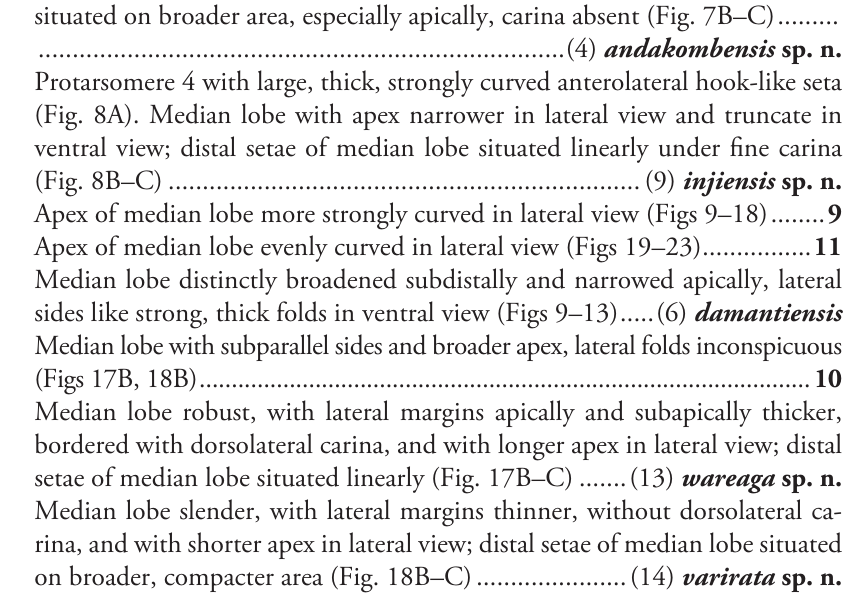
– Beetle larger, TL-H: 3.9–4.5 mm, with darker dorsal coloration, shiny, with evident microreticulation and weak punctation (Figs 25–26) ...................... 3 3 Median lobe with apex slightly curved, elongate in lateral view and rounded in ventral view; numerous fine setae situated linearly on distal part of median lobe along the lateral sides (Figs 2–3, figs 76, 82 in Balke (1998)) ...........(1) miriae – Median lobe with apex slightly curved, broad in lateral view and concave in ventral view, and with a small bunch of fine distal setae on both lateral sides (Fig. 4B–C) ....................................................................... (3) tekadu sp. n. 4 Beetle matt dorsally due to strong microreticulation and punctation .......... 5 – Beetle shiny, with evident microreticulation and weak punctation .............. 8 5 Median lobe narrow, with slightly curved, broad apex and few fine distal setae in lateral view (Fig. 5B–C) .....................................(10) kabwumensis sp. n. – Median lobe broader, with numerous thick setae in lateral view (Figs 6–8) ... 6 6 Beetle larger, TL-H: 3.6–4.0 mm (Fig. 28). Median lobe with more numer- ous and more sparsely situated thick distal setae laterally; paramere with small dorsal notch (Fig. 6C–D) .........................................(15) woitapensis sp. n. – Beetle smaller, TL-H: 3.05–3.55 mm (Figs 29–30). Median lobe with less numerous and more compactly situated thick distal setae laterally; paramere without notch, slightly concave dorsally (Figs 7C–D, 8C–D) ..................... 7 7 Protarsomere 4 with weakly curved anterolateral hook-like seta, equal to more laterally situated large seta (Fig. 7A). Median lobe with apex broader in lateral view and slightly concave in ventral view; distal setae of median lobe situated on broader area, especially apically, carina absent (Fig. 7B–C) ......... .............................................................................(4) andakombensis sp. n. – Protarsomere 4 with large, thick, strongly curved anterolateral hook-like seta (Fig. 8A). Median lobe with apex narrower in lateral view and truncate in ventral view; distal setae of median lobe situated linearly under fine carina (Fig. 8B–C) ..................................................................... (9) injiensis sp. n. 8 Apex of median lobe more strongly curved in lateral view (Figs 9–18) ........ 9 – Apex of median lobe evenly curved in lateral view (Figs 19–23) ................ 11 9 Median lobe distinctly broadened subdistally and narrowed apically, lateral sides like strong, thick folds in ventral view (Figs 9–13) .....(6) damantiensis – Median lobe with subparallel sides and broader apex, lateral folds inconspicuous (Figs 17B, 18B) ............................................................................................... 10 10 Median lobe robust, with lateral margins apically and subapically thicker, bordered with dorsolateral carina, and with longer apex in lateral view; distal setae of median lobe situated linearly (Fig. 17B–C) .......(13) wareaga sp. n. – Median lobe slender, with lateral margins thinner, without dorsolateral ca- rina, and with shorter apex in lateral view; distal setae of median lobe situated on broader, compacter area (Fig. 18B–C) ......................(14) varirata sp.